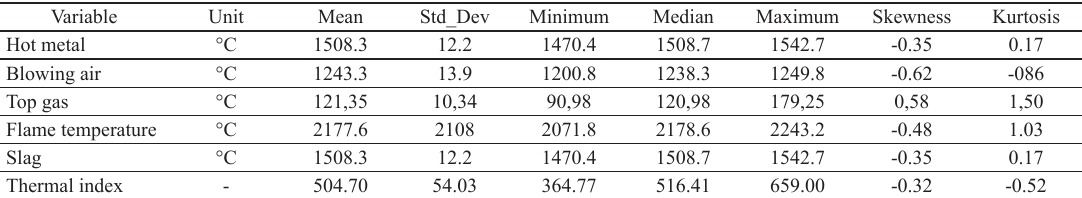
Table 8. Temperature